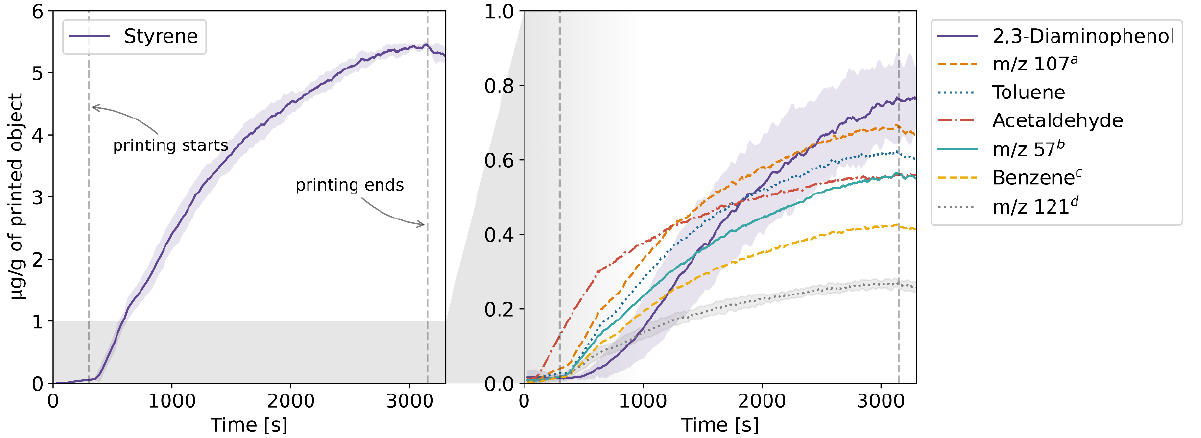
phenylpropene; k = 2.0 × 10 − 9 cm 3 s − 1 ; g tert-butyllbenzene, p-propyltoluene; k = 2.0 × 10 − 9 cm 3 s − 1 . nylpropene; k = 2.0 × 10 −9 cm 3 s −1 ; g tert-butyllbenzene, p-propyltoluene; k = 2.0 × 10 −9 cm 3 s −1 .